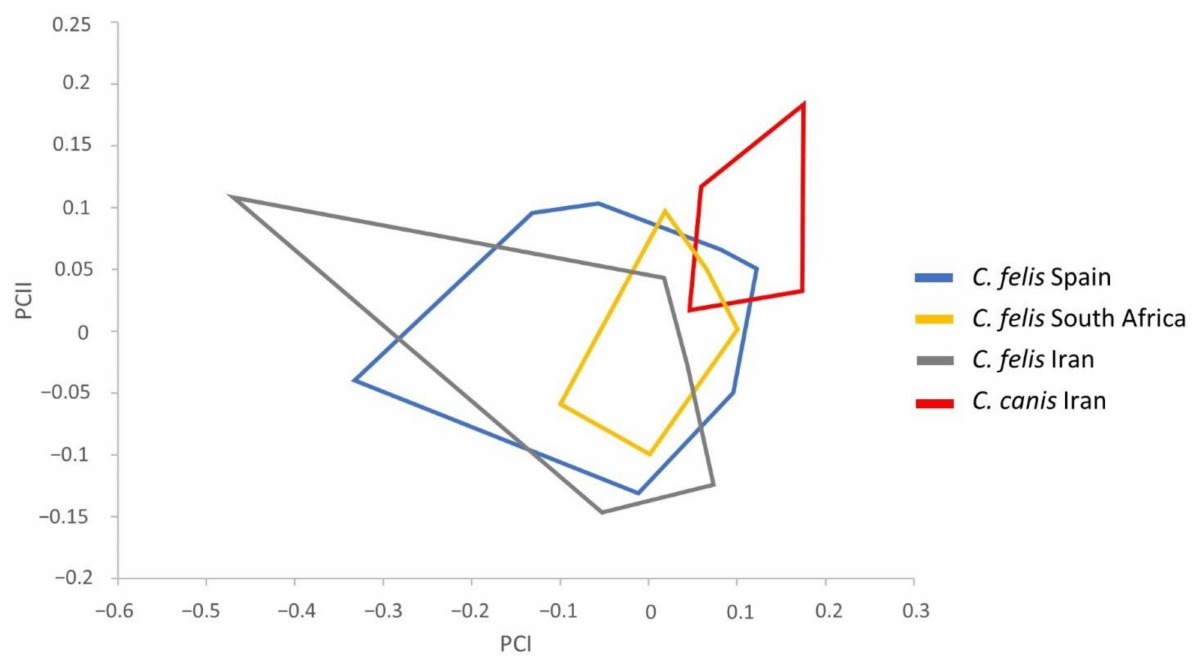
Figure 2. Factor map corresponding to Ctenocephalides spp. male adults from Spain, South Africa, and Iran. Samples are projected onto the first and second principal components: PCI (63%) and PCII (25%). Each group is represented by its perimeter.